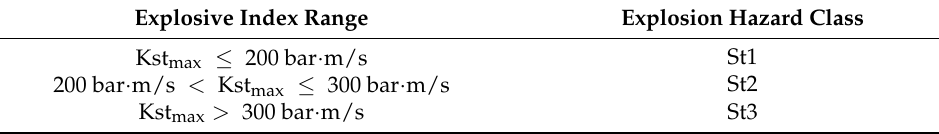
Table 4. Risk classification of explosive